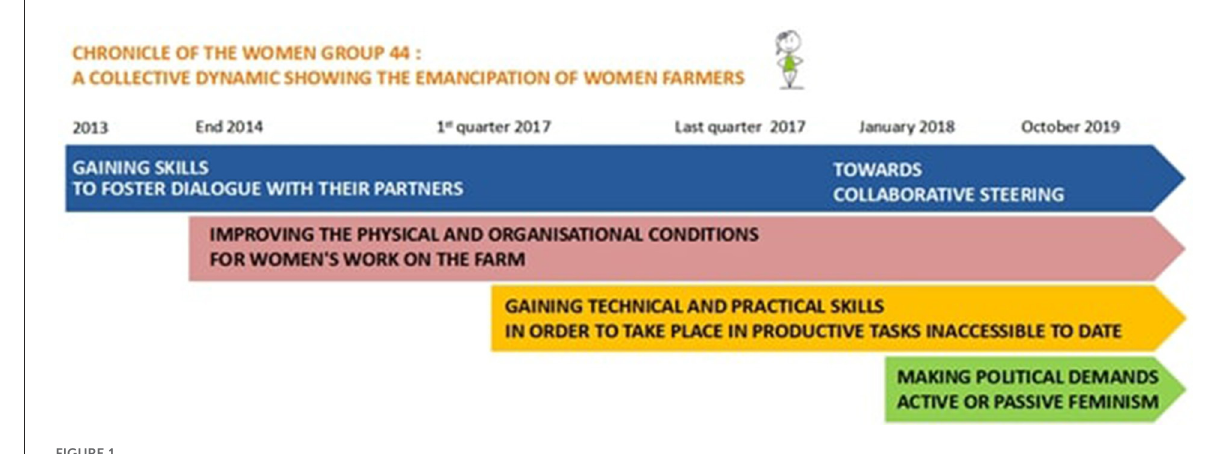
FIGURE1 The different dynamics of Groupe Femmes 44